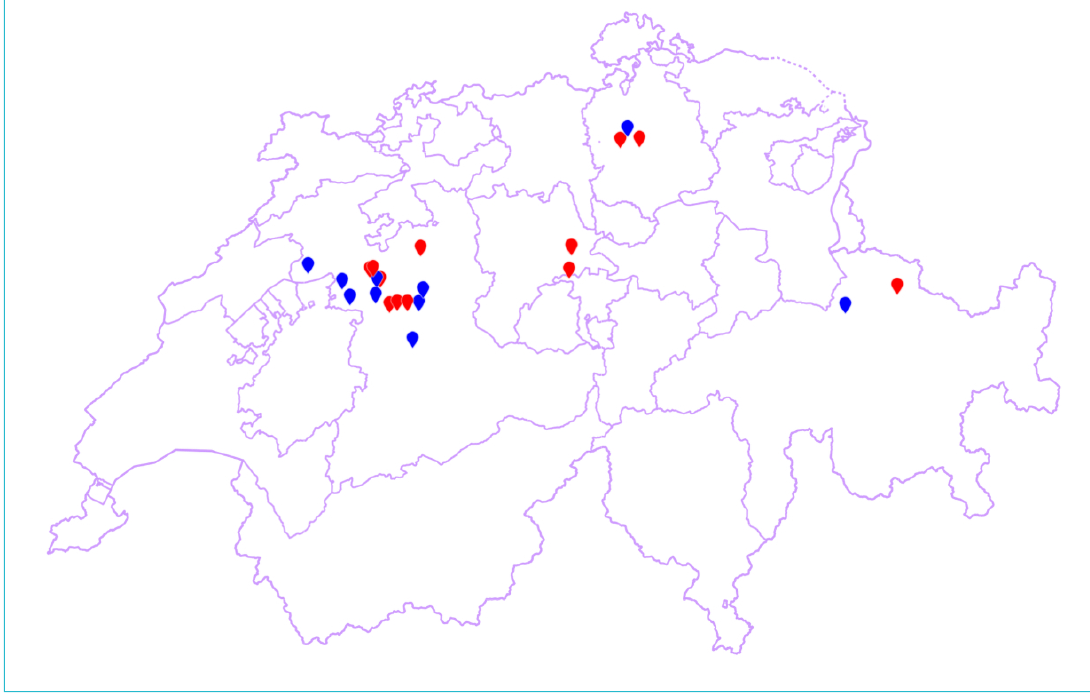
Figure 2: Map of Switzerland with participating practices. Red: practices with CSMA; blue: practices without CSMA.